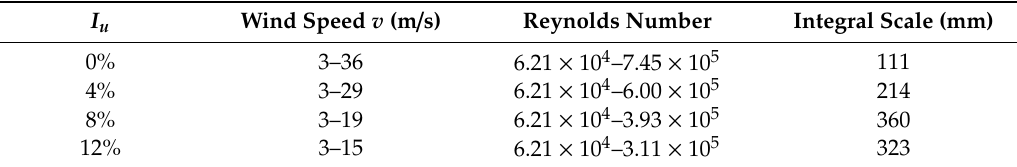
Table 1. Test wind speed and Reynolds number in the tests.